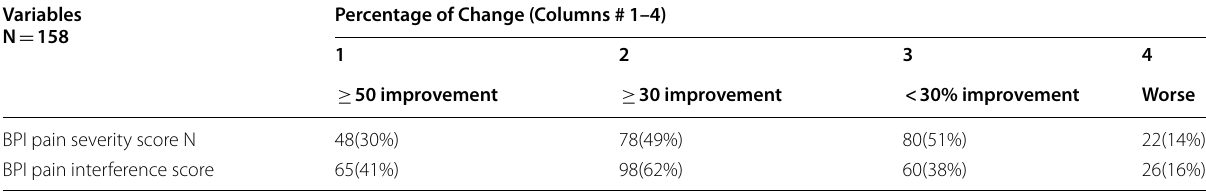
50%, 30%, < 30% or worsening at exit ≥ ≥